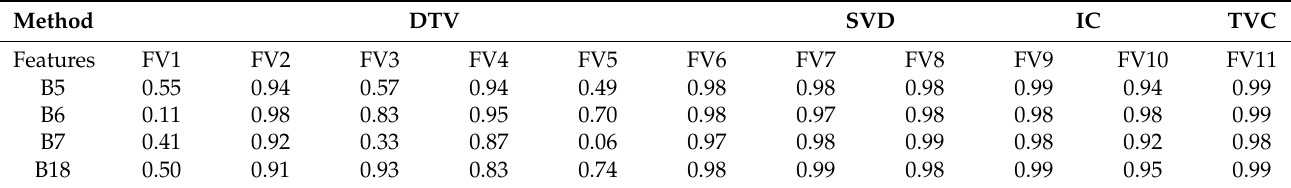
Table 3. Pearson correlation coefficients between feature variables and SOH for the NASA dataset.